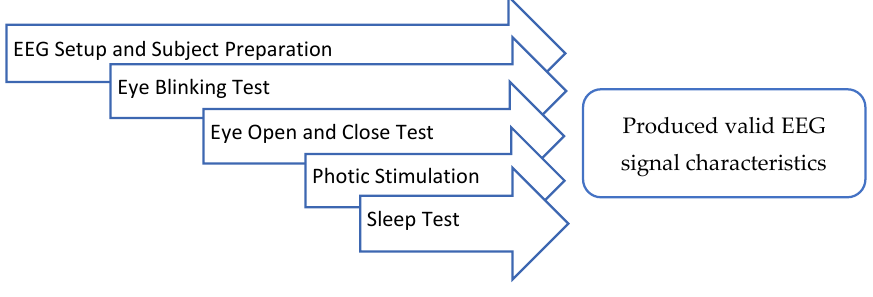
Figure 5. Reproducibility tests.